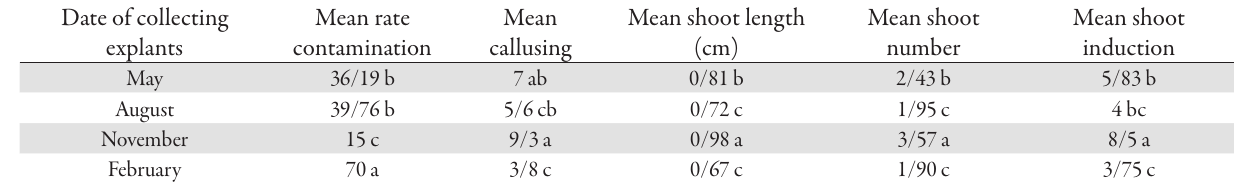
Tab. 4. Effect of different date of collecting explants on shoot proliferation Date of collecting